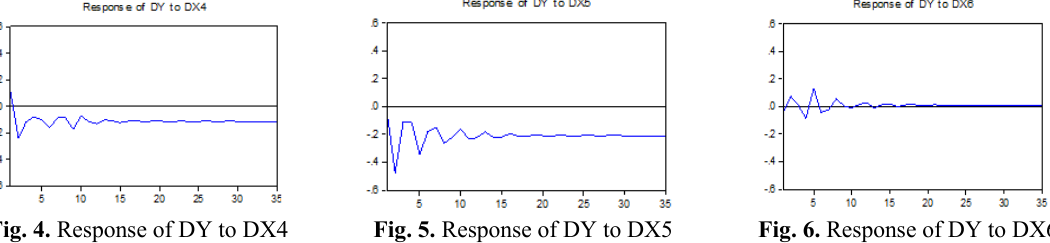
Fig. 4. Response of DY to DX4 Fig. 5. Response of DY to DX5 Fig. 6. Response of DY to DX6